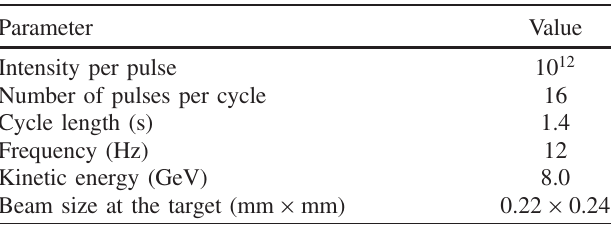
TABLE I. Primary beam parameters at the production target.